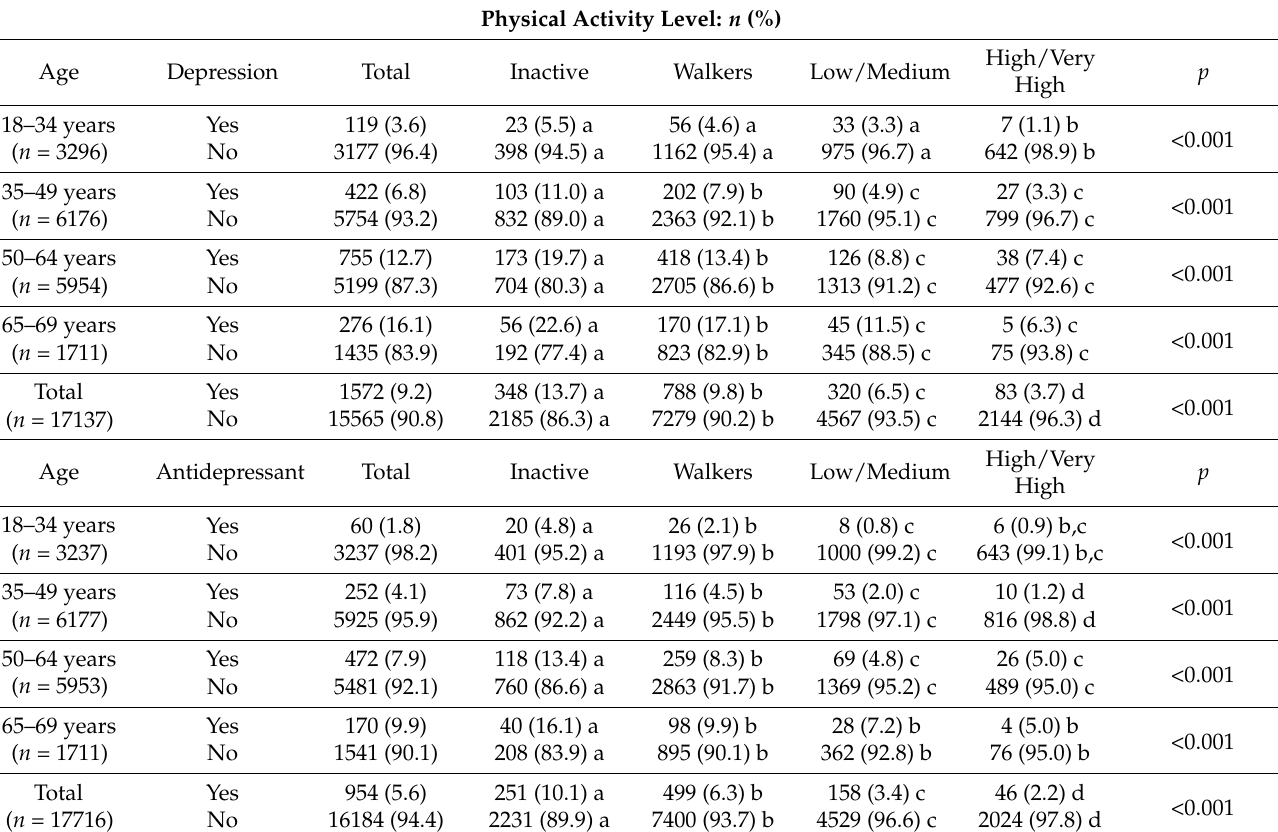
Table 5. Relationship between prevalence of depression, taking antidepressants and level of physical activity, according to age group in the general Spanish population of the 2017 ENSE aged between 18 and 69 years, and by age